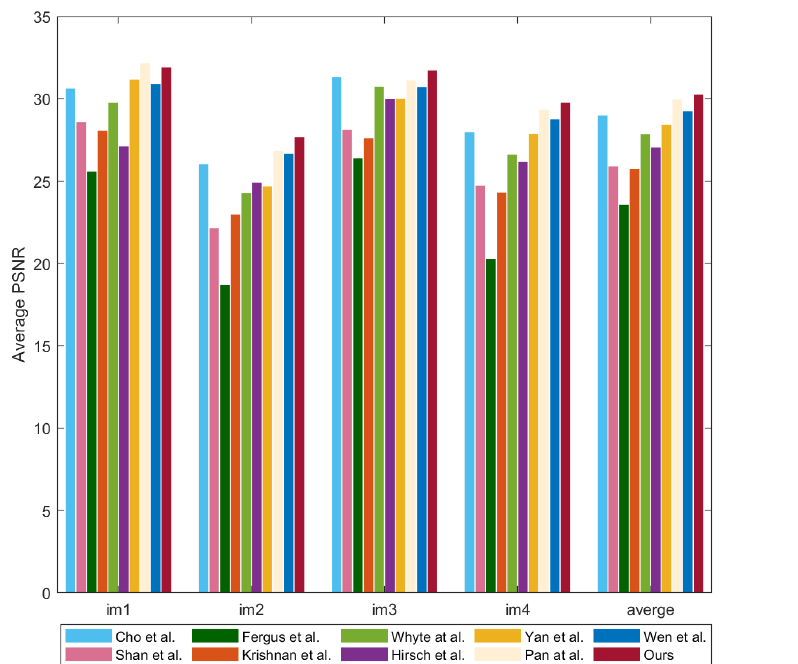
Figure 3. Quantitative evaluations on benchmark dataset [44]. Our method performs competitively against the state-of-the-art deblurring approaches.